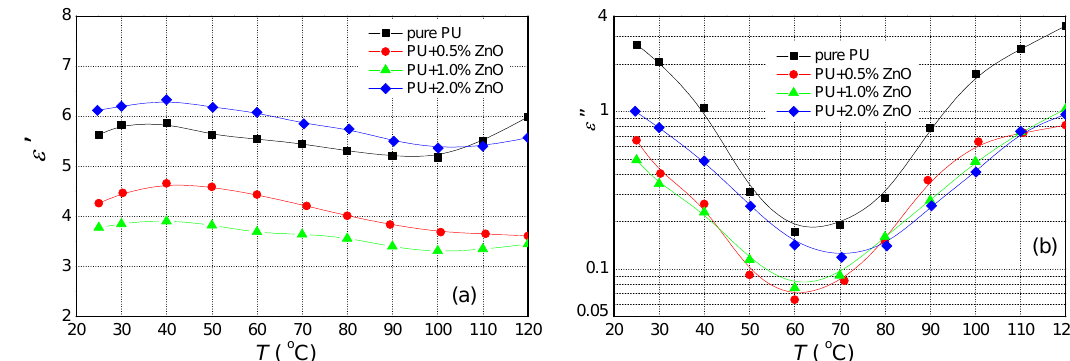
Figure 3. Temperature dependence of ( a ) the real and ( b ) imaginary parts of the complex permittivity for polyurethane resin and its various mixtures with ZnO nanoparticles measured at frequency 50